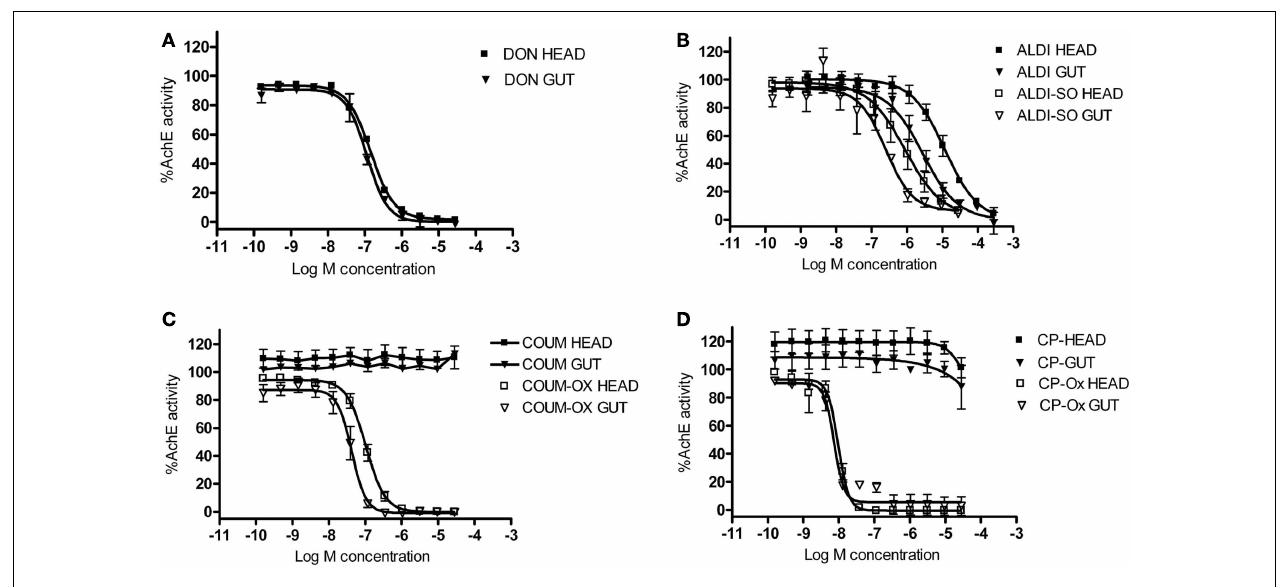
(CP) and chlorpyrifos oxon (CP-OX). AChE activity was normalized to control measurements. Hill equation fits of the data were made using GraphPad Prism. N = 3 treatment replicates; three technical replicates were performed for each sample.